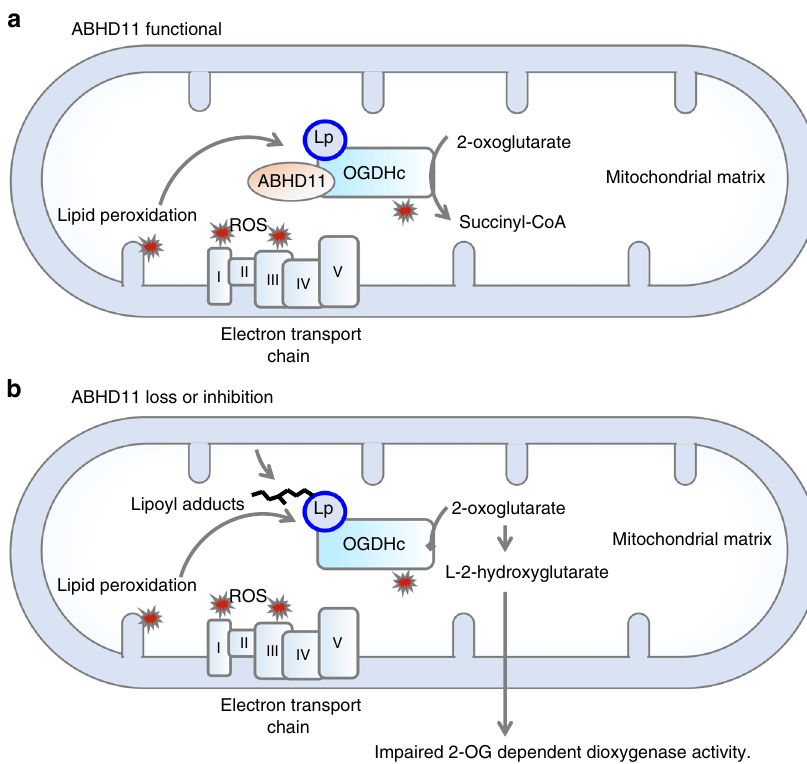
Fig. 6 ABHD11 regulation of OGDHc activity. Working model for functional lipoylation of the OGDHc. a Cyclical reduction and oxidation of lipoate is required for OGDHc catalytic activity, and this process requires ABHD11 which associates with the OGDHc, maintaining functional lipoylation and allowing the conversion of 2-OG to succinyl CoA. b When ABHD11 is depleted or inhibited, lipoyl adducts form, preventing functional lipoylation. These adducts may arise from lipid peroxidation products (e.g. 4-HNE) formed by ROS generated by the OGDHc or by the electron transport chain, or by other as yet unde fi ned mechanisms. Loss of functional lipoylation leads to 2-OG accumulation and the formation of L-2-HG, which can inhibit 2-OG dependent dioxygenases involved in the HIF response and DNA